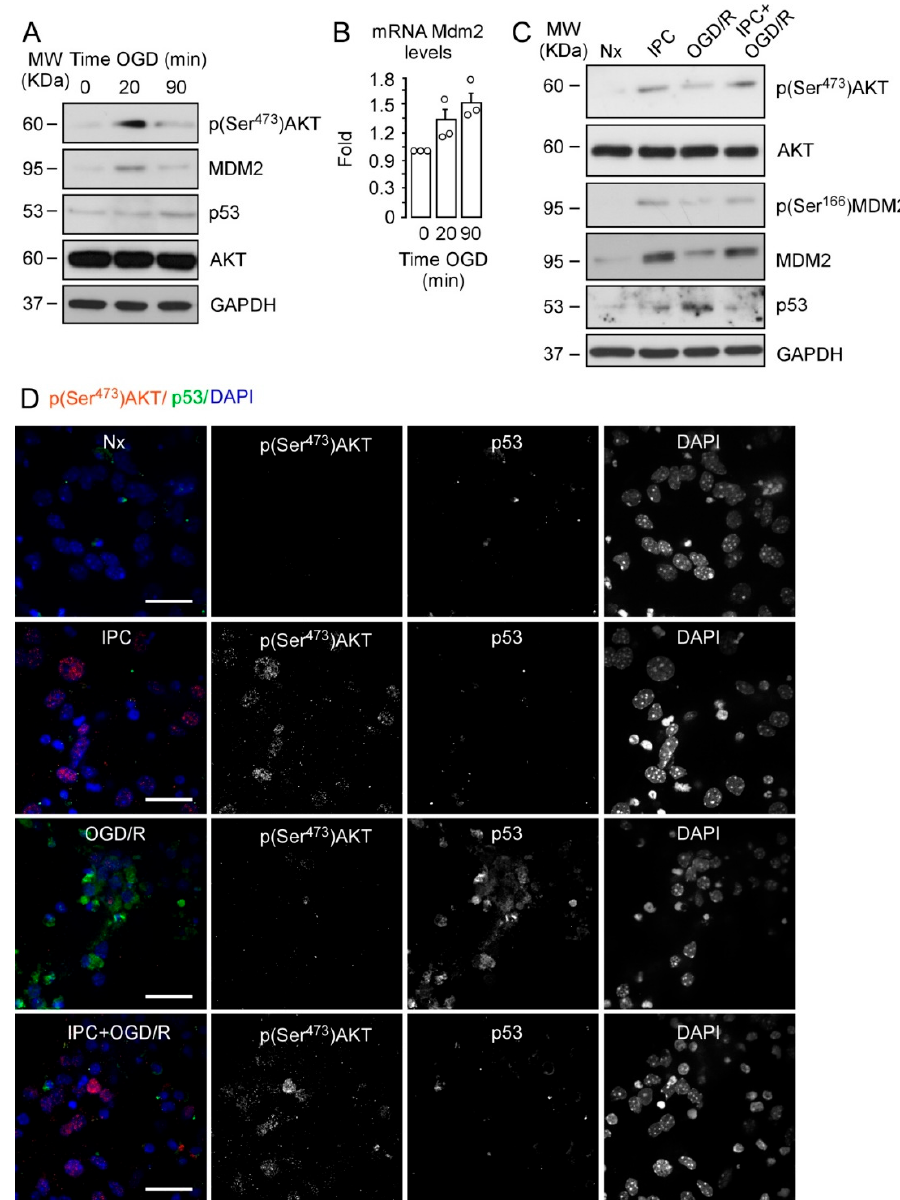
Figure 1. IPC promotes phosphorylation of AKT at Ser 473 and MDM2 at Ser 166 and reduces p53 stabilization. Mouse cortical neurons (9–10 DIV) were exposed to a validated in vitro model of IPC and ischemia, as indicated in Figure S1B. ( A ) Phosphorylation of AKT at Ser 473 , p(Ser 473 )AKT, MDM2, and p53 protein levels as detected by Western blotting after Nx and OGD (20 or 90 min). ( B ) Mdm2 mRNA levels as quantified by real-time qPCR. ( C ) AKT, p(Ser 473 )AKT, MDM2, its phosphorylated form at Ser 166 , p(Ser 166 )MDM2, and p53 were analyzed by Western blotting. AKT and GADPH were used as loading control. Relative protein abundance quantification from three or five different neuronal cultures is shown in Figure S1A,C, respectively. MW, molecular weight. ( D ) Representative images of cortical neurons stained with p(Ser 473 )AKT (red), p53 (green), and DAPI (blue, nuclear marker). Scale bar, 50 μ m. Percentage of positive AKT and p53 neurons is quantified in Figure S2A.